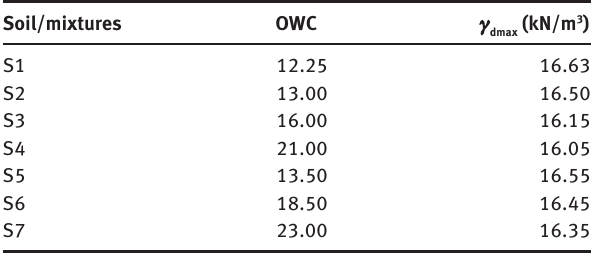
Table 3 Physical properties of silt and artificially mixed soils.